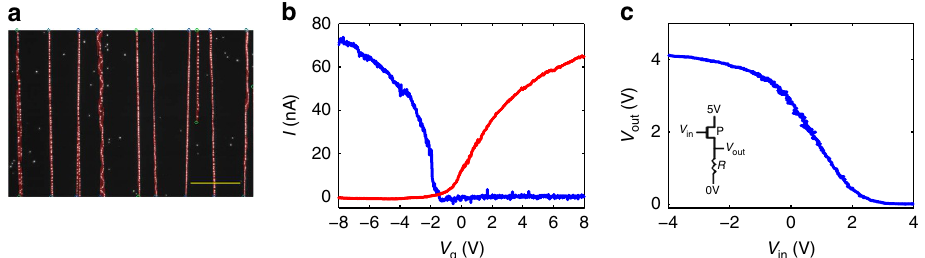
Figure 7 | Automatic design and fabrication of carbon nanotubes based devices. ( a ) Image processing results. Dark field optical microscopy image of marked carbon nanotubes (CNTs) (white dotted lines) superimposed with the image processing analysis results (red lines). Scale bar, 30 m m. ( b ) Transfer characteristics of automatically designed p- (blue line) and n- (red line) type CNT field effect transistors (FETs). ( c ) Automatically designed inverter based on p-type CNTFET and external resistor. Inset: schematic diagram for the